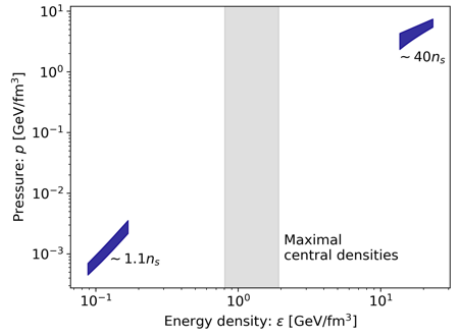
Figure 1. The equation of state can be probed using chiral e ff ective field theory at low densities, up to and around the saturation density n ∼ n s . At high densities n ∼ 40 n s , perturbation theory becomes quantitatively reliable. Cores of neutron stars have densities between these two